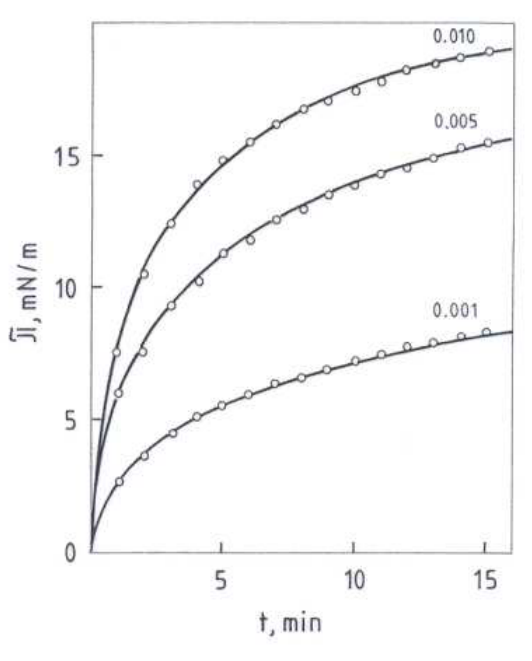
Fig. 1 Experimental dynamic interfacial pressure (Π in mN/m) of dibucaine aqueous solutions (pH 2) at the benzene/water interface, as a function of time (t, min). Figures indicate the dibucaine bulk concentration ( c 0 in mole dm − 3 ).